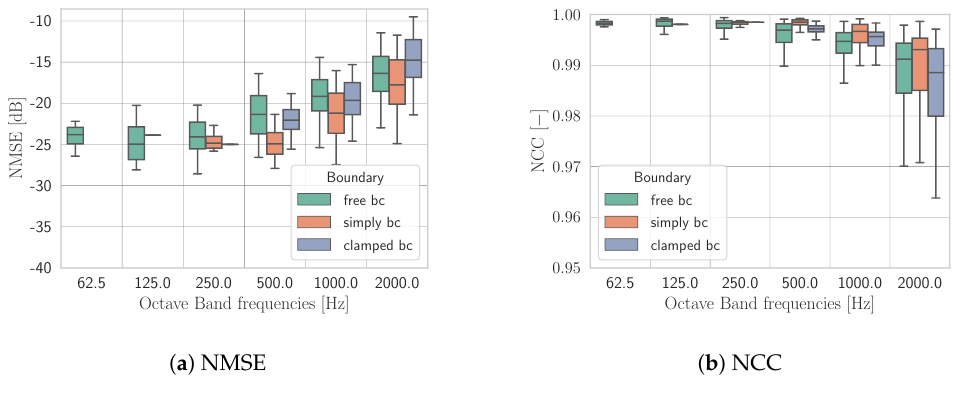
Figure 5. NMSE ( a ) and NCC ( b ) obtained by KHCNN adopting P ( M = 64 ) octave bands and grouped accordingly to